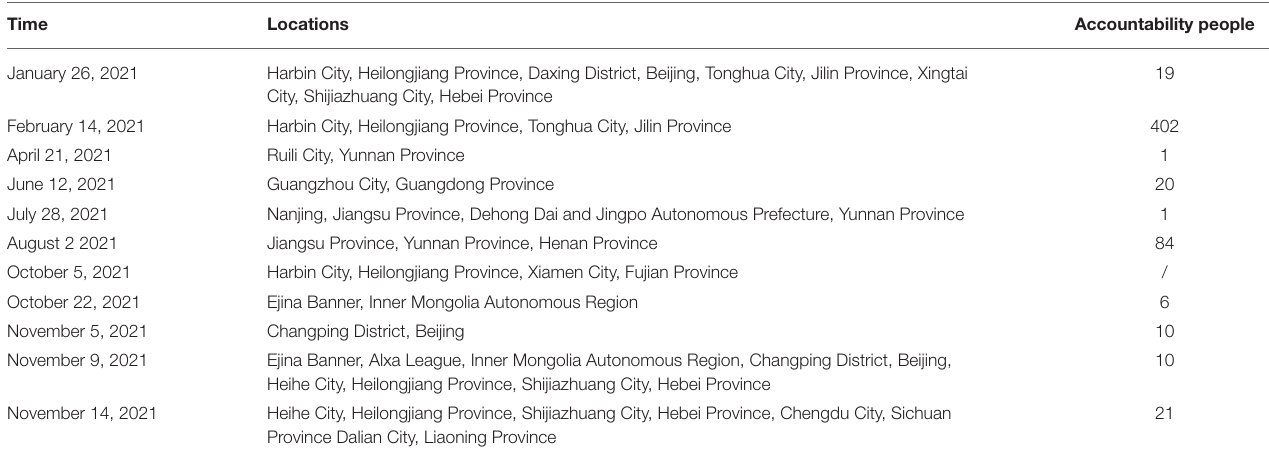
TABLE 1 | COVID-19 waves in China since